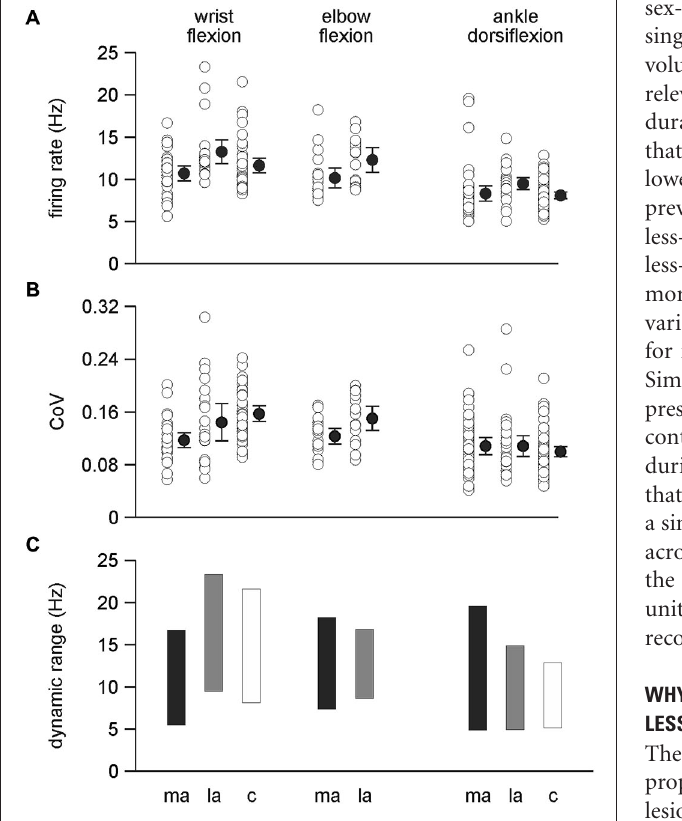
FIGURE 4 | Single motor unit discharge behavior. (A) Firing rates were significantly higher during wrist flexion than ankle dorsiflexion ( p < 0 .001) and also higher on the less-affected side compared to both the more-affected side and control data ( p < 0.001). There was no difference between the more-affected side and control data for wrist flexion and ankle dorsiflexion. Firing rates were higher on the less-affected side compared to the more-affected side during elbow flexion ( p = 0.021). (B) The co-efficient of variation of motor unit discharge rates was higher for wrist flexion data than ankle dorsiflexion data ( p < 0.001). During wrist flexion the co-efficient of variation was lowest on the more-affected side compared to the less-affected side ( p = 0.02) and control data ( p < 0.001). There was no difference between the less-affected side and control data during wrist flexion, or between sides during ankle dorsiflexion. The co-efficient of variation during elbow flexion was lower on the more-affected side compared to the less-affected side ( p = 0.024). A and B : data are presented for each motor unit (open symbols); mean (filled symbols) and 95% confidence intervals. (C) the dynamic range of mean motor unit firing rates. The dynamic range was compressed on the more-affected side only for motor units recorded during wrist flexion. ma: more-affected side; la: less-affected side; c: control data (healthy